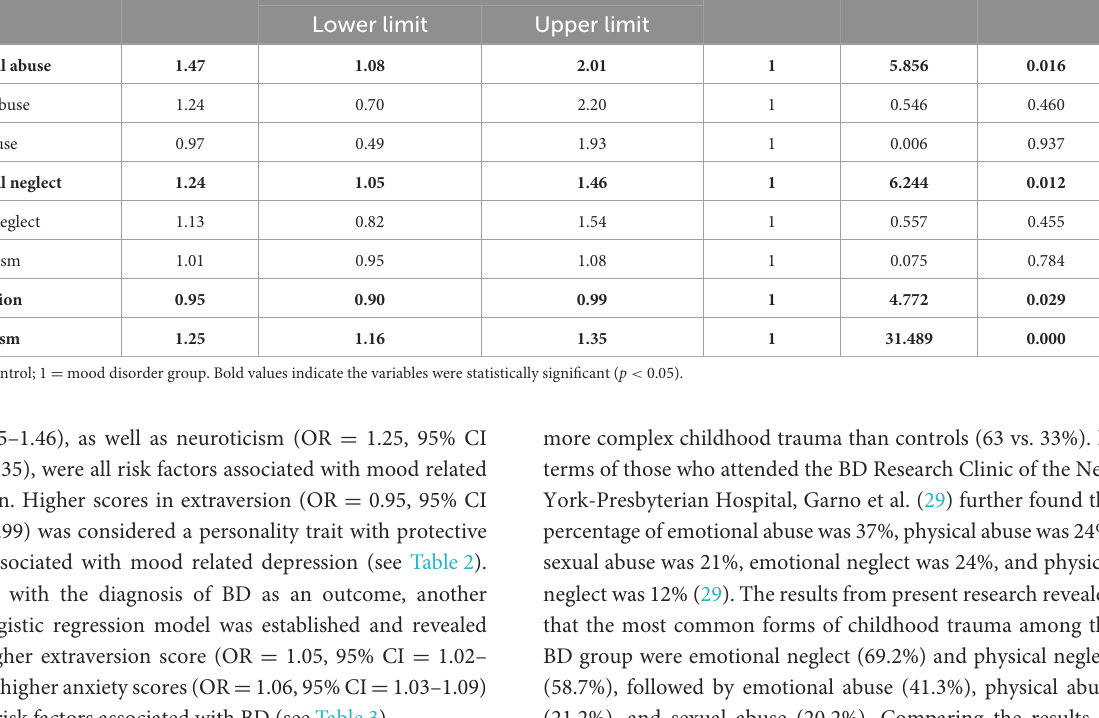
TABLE 2 Logistics regression analysis between health control and mood disorder group.